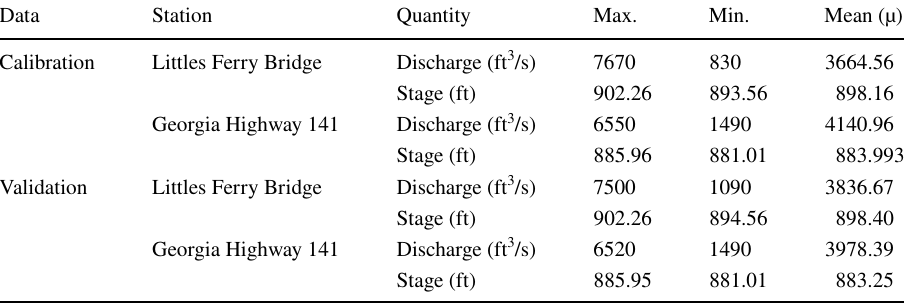
characteristics of flood data